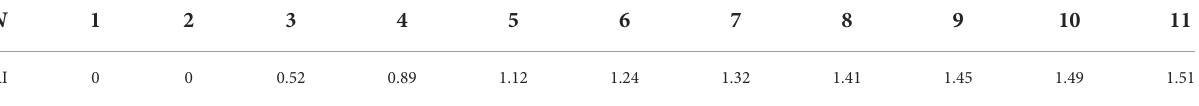
TABLE 3 Random consistency indicator RI coefficient table.